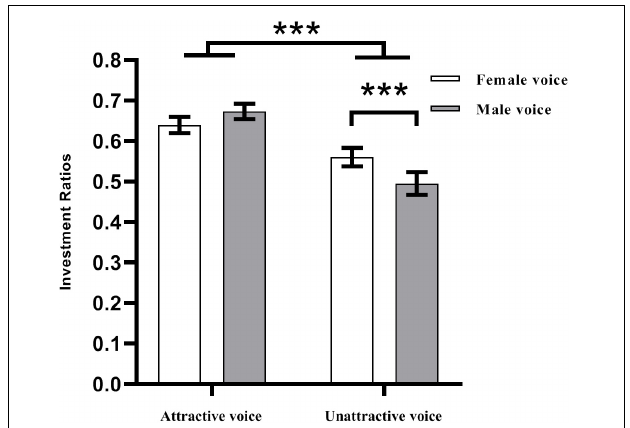
FIGURE 2 | The investment ratio of the participants in four conditions (attractive-female, attractive-male, unattractive-female, and unattractive-male). *** p < 0.001. Error bars represent one standard error about the